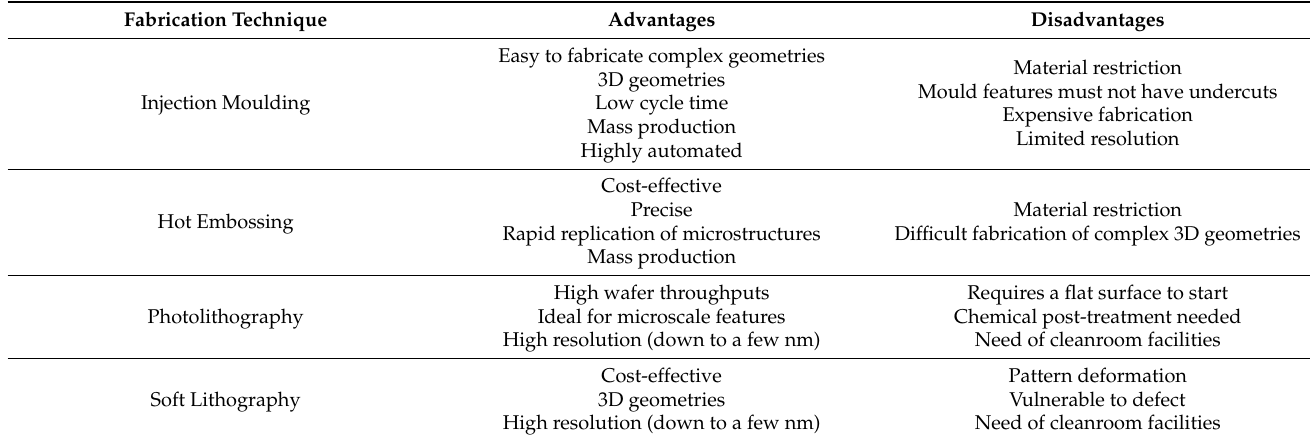
Table 4. Summary of the advantages and disadvantages of the different microfluidics fabrication techniques, adapted from the literature